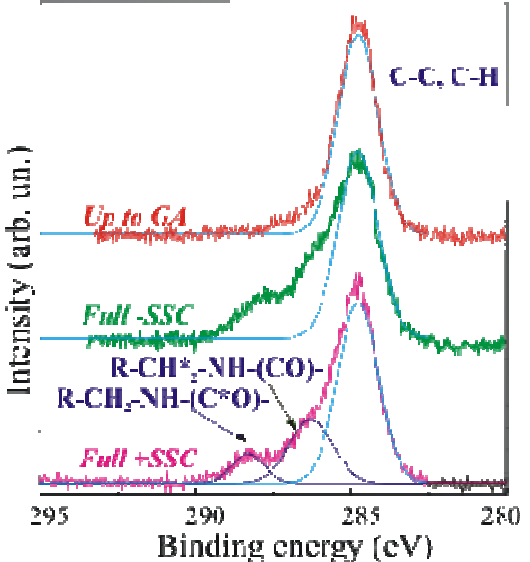
Figure 2. High acquisition mode XPS C1 s spectral regions of: up-to-GA (red line), fully processed without SSC (green line, Full-SSC) and fully processed with SSC (magenta line, Full+SSC) samples. The light and dark blue lines are the simulated